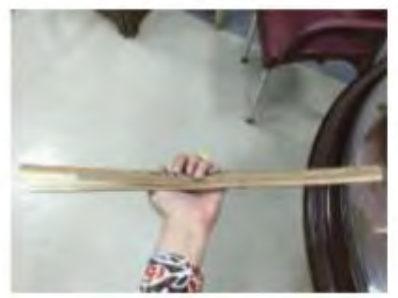
Figure 25. The longitudinal cracking in a specimen (Author’s own, n.d.)